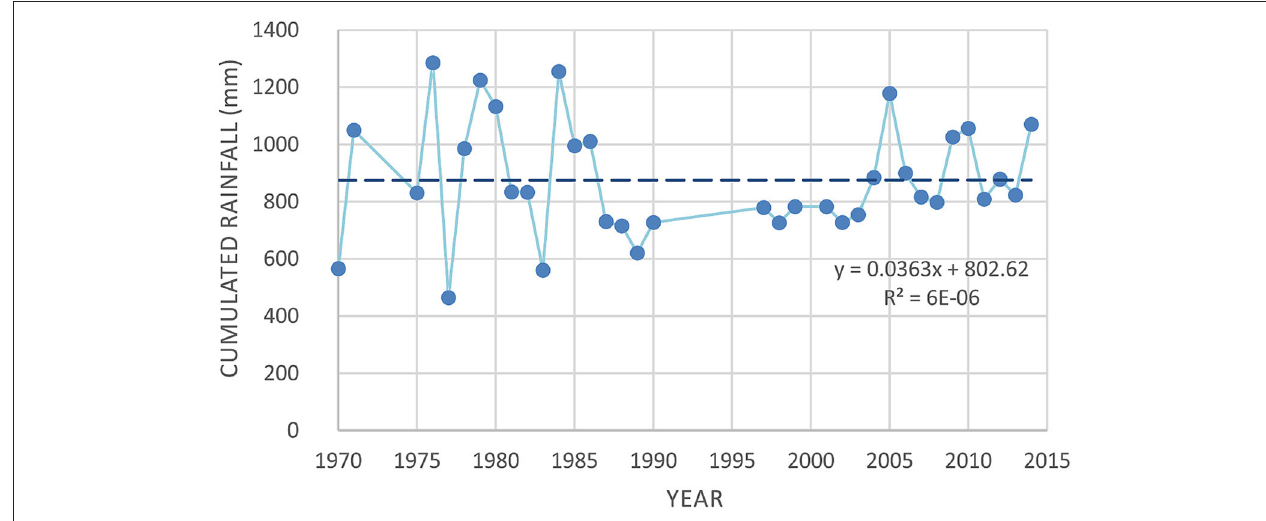
FIGURE 3 | Cumulated annual rain at the Pozzuoli rain